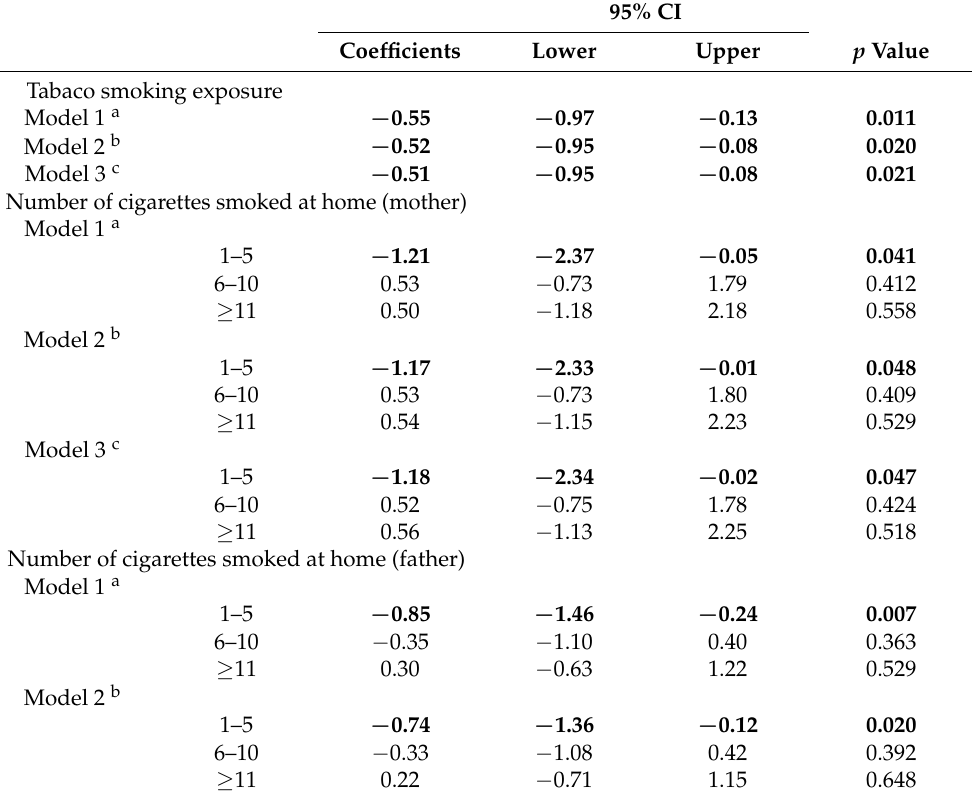
Table 3. Association between tobacco smoke exposure and de-seasonalized serum 25(OH)D concen- trations in children aged 2